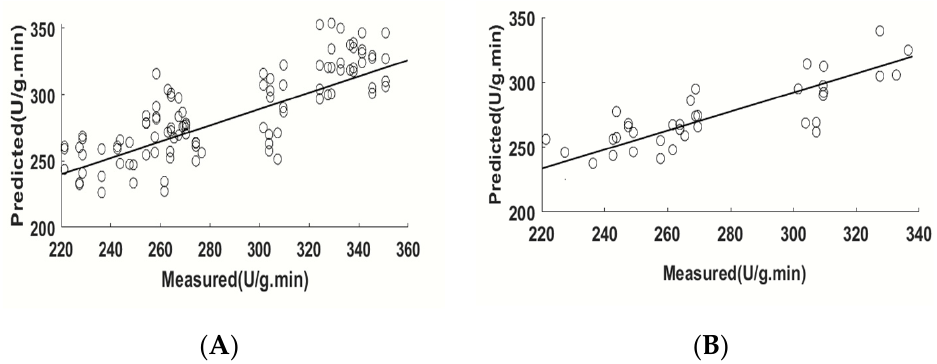
Figure 7. IVISSA + SPA − PLSR modeling results; the PLSR model of the calibration set ( A ), the PLSR model prediction of the calibration set ( B ). The circle is a intersection of measured and predicted values for POD activity.